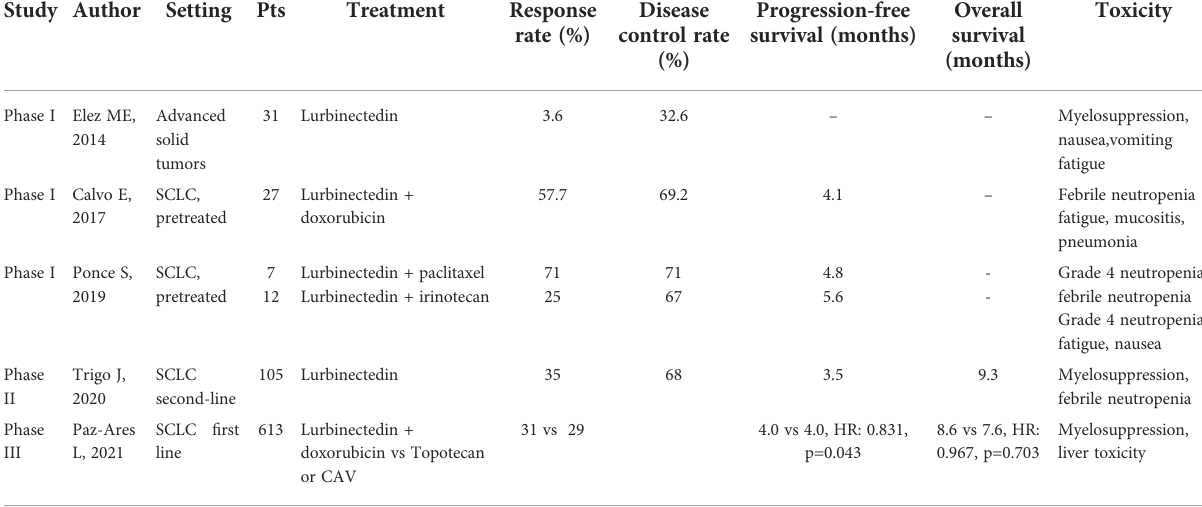
TABLE 1 Clinical studies with Lurbinectedin in solid tumors and